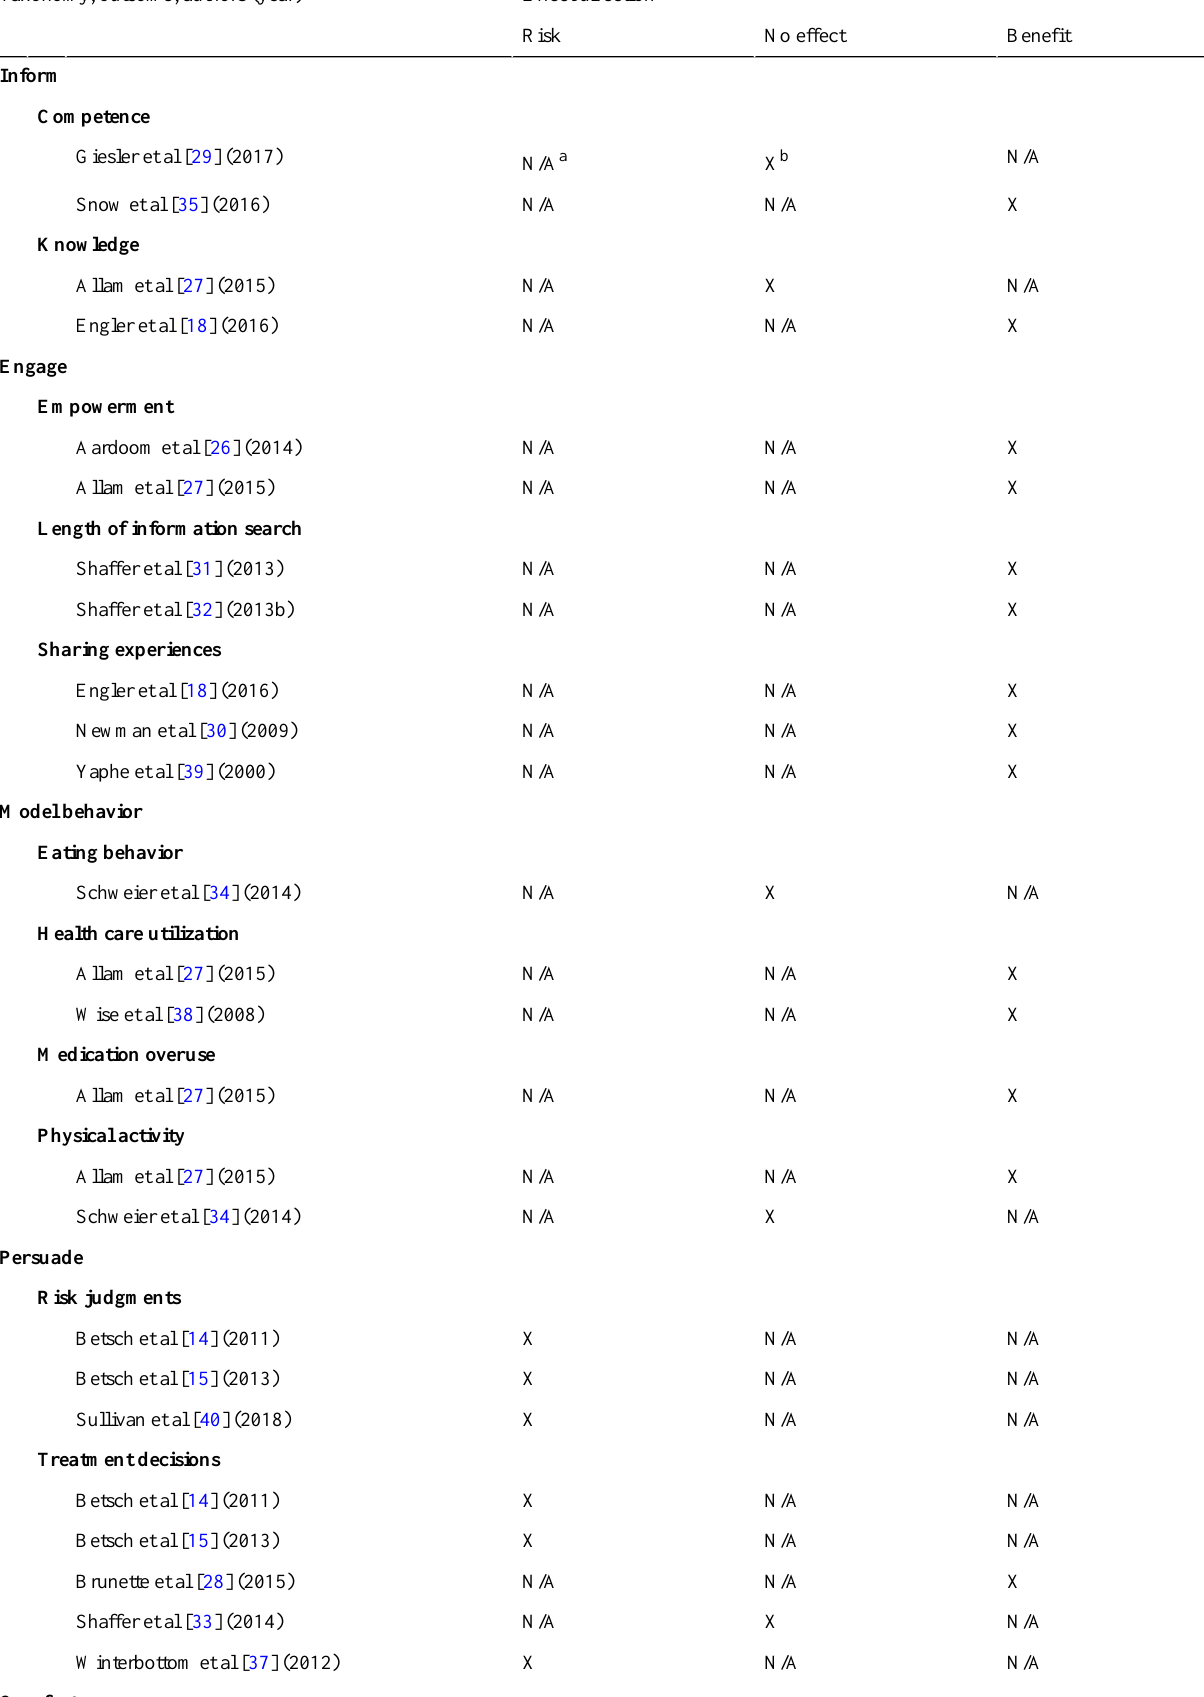
Effect directionTaxonomy, outcome, authors